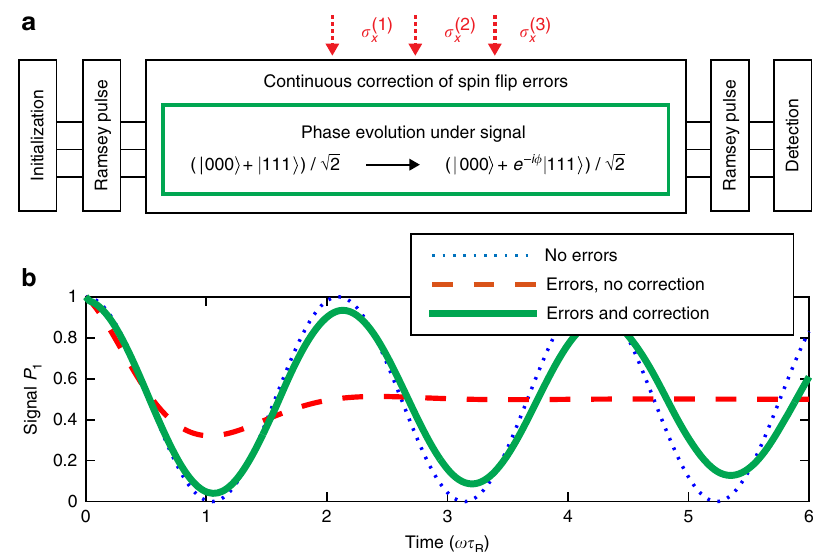
Fig. 6 Application of the proposed error correction scheme to quantum metrology. a Ramsey scheme. From an initial state | 000 〉 , a Ramsey pulse prepares ffiffiffi ffiffiffi P p p N σ ð j Þ i ϕ 111 j iÞ = 2 during a Ramsey time τ R . Rotation by a second Ramsey pulse 2 . Under H ¼ ð ω = 2 Þ ð 000 j i þ 111 j iÞ = z , the state evolves to ð 000 j i þ e (cid:3) j ¼ 1 and measurement of the population P 1 of one ion in the { | 0 〉 , | 1 〉 } basis allows deducing ω according to P 1 ¼ cos 2 ð ϕ = 2 Þ with ϕ = 3 ωτ R . b In the absence of errors, the Ramsey measurement has full fringe contrast (dotted blue line). Spin- fl ips at a rate Γ = ω /2 damp out the oscillations (dashed red line). Applying the presented scheme for error correction protects the evolution and restores the fringe contrast (solid green line, assuming a sideband coupling of G = 5000 Γ